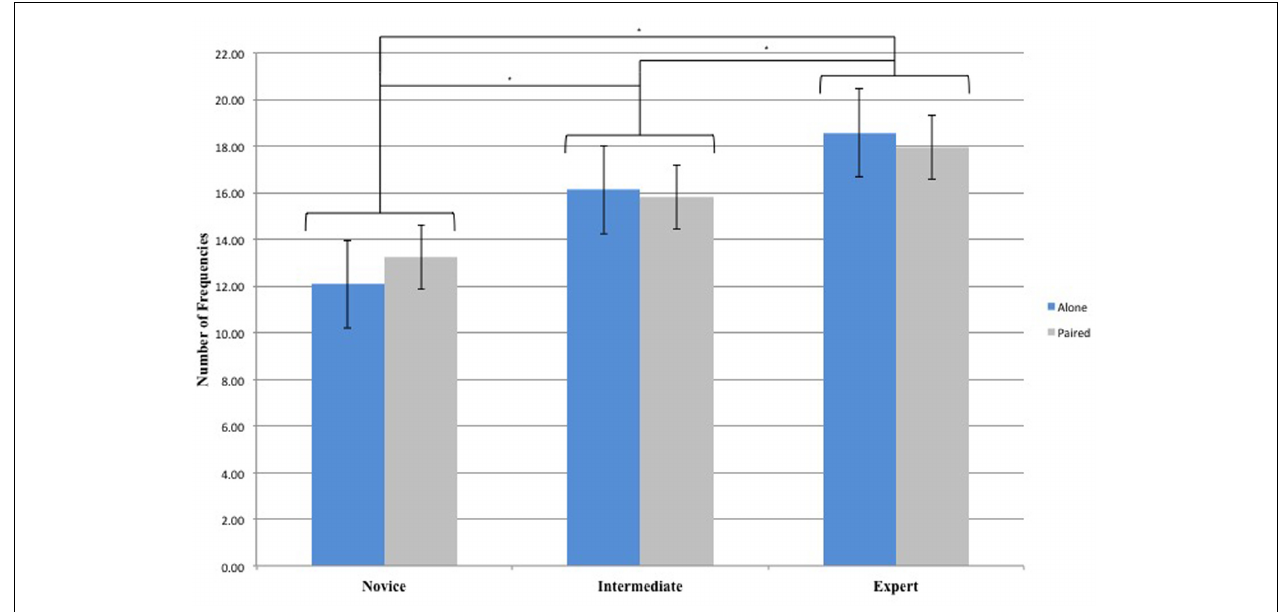
FIGURE 2 | Number of Frequencies for the 3 Groups (Novice, Intermediate, and Expert) and the 2 Conditions (Alone and Paired). ∗ Asterisks indicate significant differences P < 0.05.